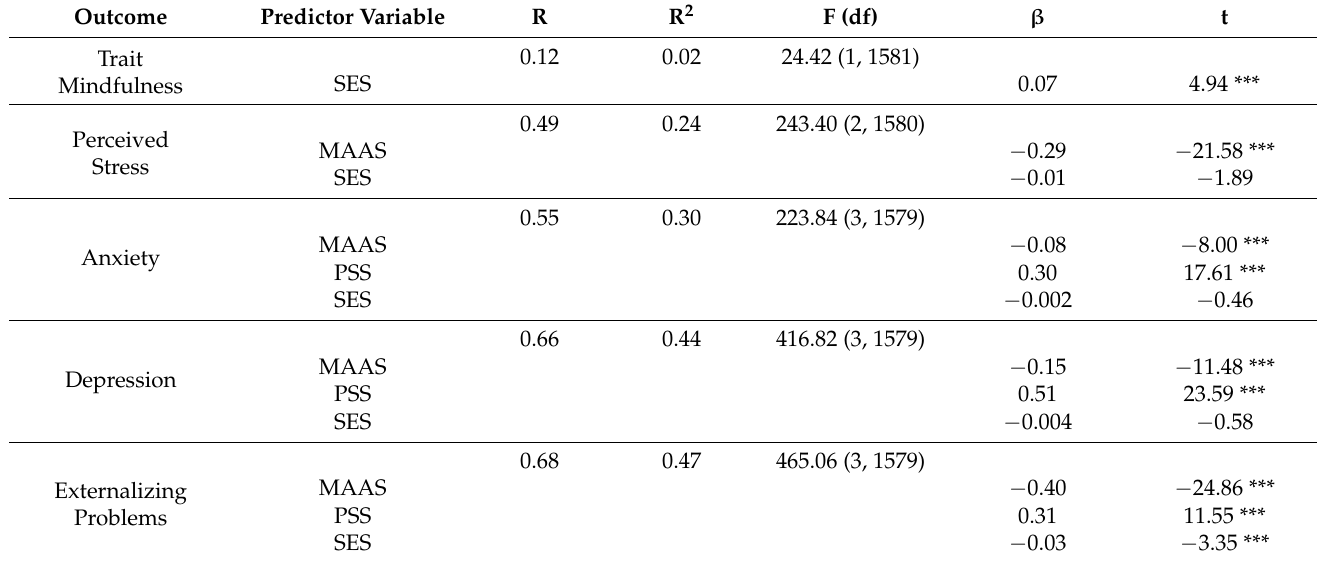
Table 3. Analysis of the regression relationship among the